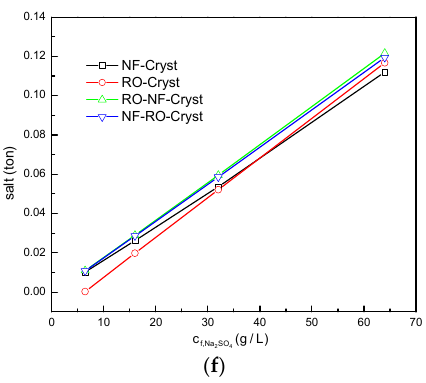
( f ) c ; ( c ) c ; ( d ) E water ; ( e ) E salt ; ( f ) salt production; as a function of Figure 7. ( a ) V 0 /V f ; ( b ) Figure 7. ( a ) V 0 /V f ; ( b ) c r , NaCl ; ( c ) c r , Na ; ( d ) E water ; ( e ) E salt ; ( f ) salt production; as a function of r,NaCl 2 4 r,Na SO 2 SO 4 c at different process configurations under fixed c (32 g·L − 1 ). c f , Na at different process configurations under fixed c f , NaCl (32 g · L − 1 f,NaCl 2 SO 4 2 4 , f Na SO